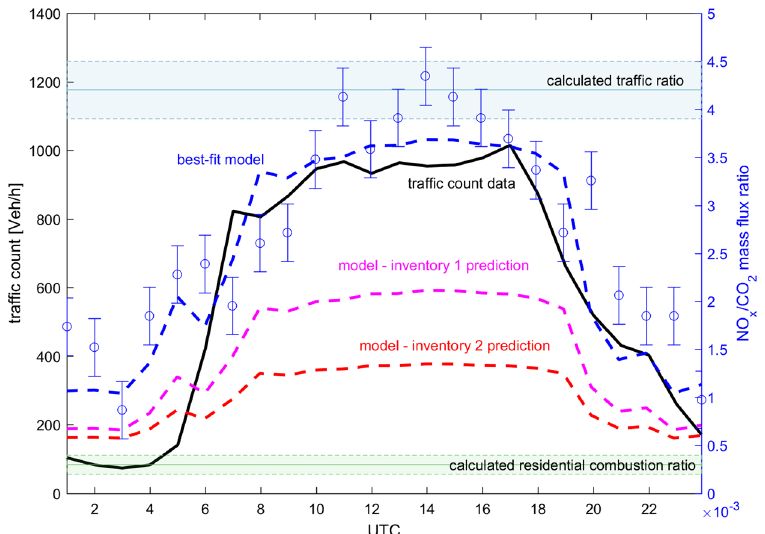
Figure 2. Diurnal cycle of median traffic count data (black line - left axis), measured (blue circles) and model fitted (dashed blue line) mass flux ratio of NO x /CO 2 (right axis). The corresponding calculated end members for traffic and residential combustion ratios are indicated by blue and green horizontal lines. The shading reflects one standard deviation. In addition colored dashed lines show predictions using fixed emission ratios from COPERT (magenta) and ACCMIP